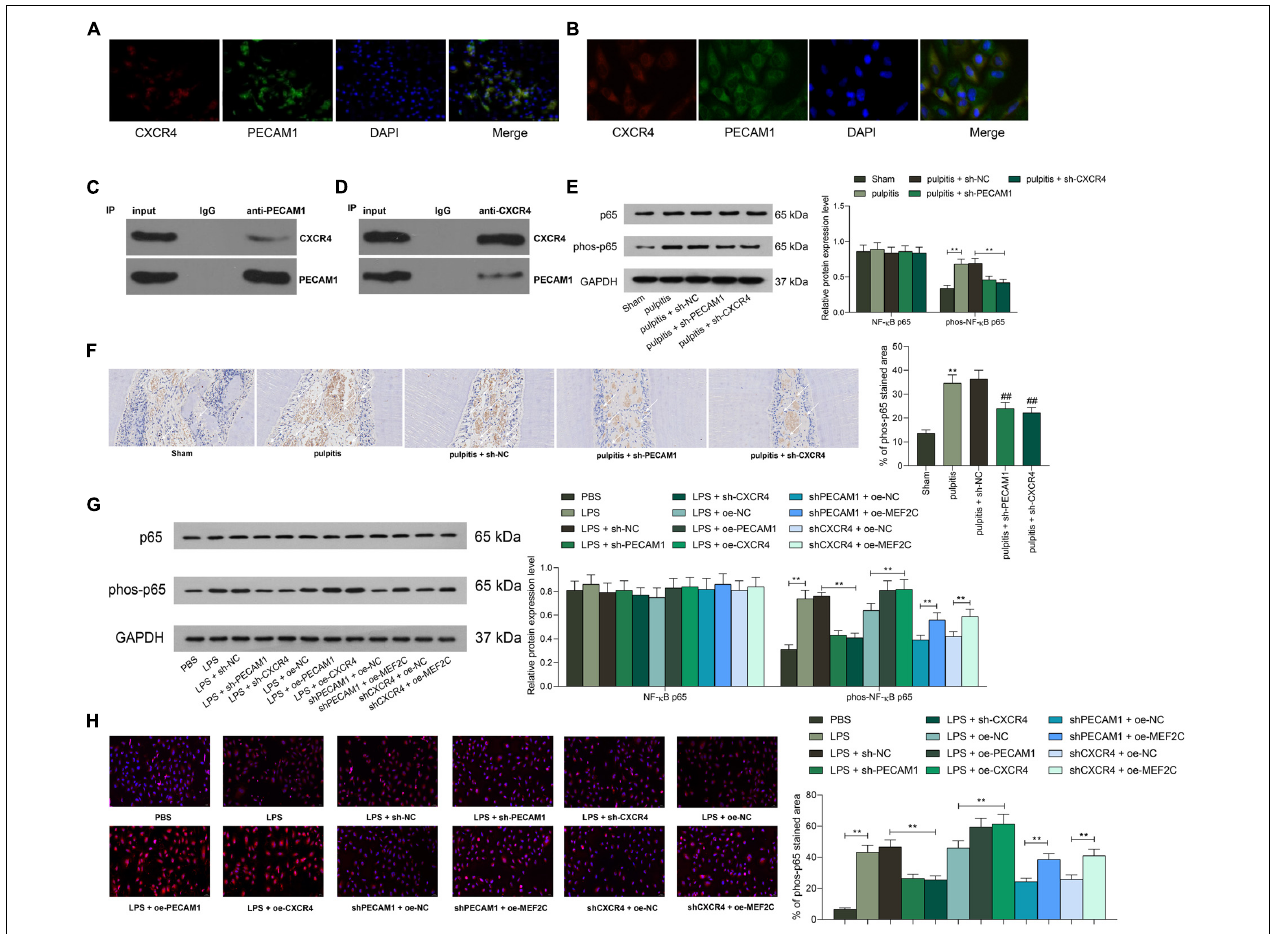
FIGURE 8 | PEACM1 binds to CXCR4 to activate the NF- κ B signaling pathway. (A,B) Co-localization of PECAM1 and CXCR4 in rat dental pulp tissues (A) and in HDPFs (B) determined by double immunofluorescence labeling. (C–D) Binding relationship between PECAM1 and CXCR4 determined by IP assays. (E–F) Phosphorylation of NF- κ B p65 in rat dental pulp tissues determined by western blot analysis (E) and IHC staining, respectively. (G) Phosphorylation of NF- κ B p65 in HDPFs measured by western blot analysis. (H) Sub-cellular localization of phosphorylated p65 in cells determined by immunofluorescence staining. Data were collected from three individual experiments and expressed as mean ± SD. Data were analyzed by one-way (F,H) or two-way ANOVA (E,G) followed by Tukey’s multiple comparison test. ** p <